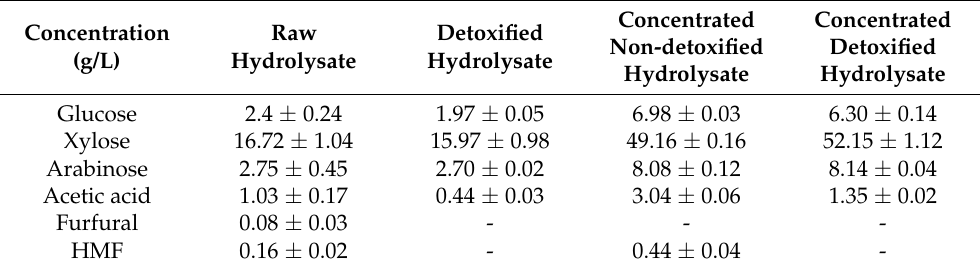
Table 1. Chemical composition of detoxified and non-detoxified rice straw hydrolysate obtained by sulfuric acid